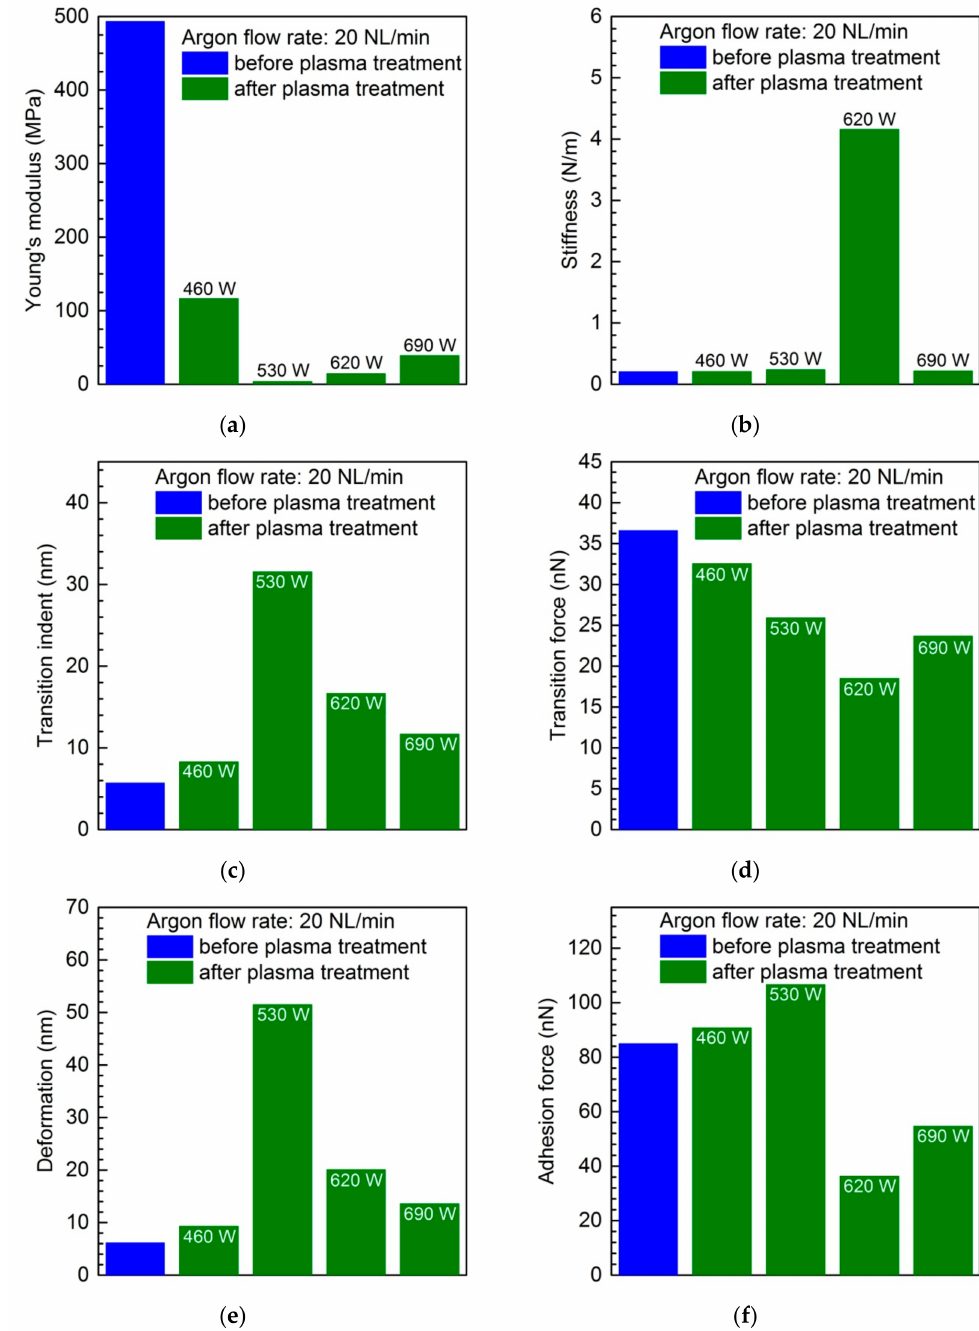
Figure 7. Dependence of the polycarbonate surface mechanical properties parameters: ( a ) Young’s modulus; ( b ) sti ff ness; ( c ) transition indent; ( d ) transition force; ( e ) deformation; and ( f ) adhesion force on the microwave power. Argon flow rate NL /